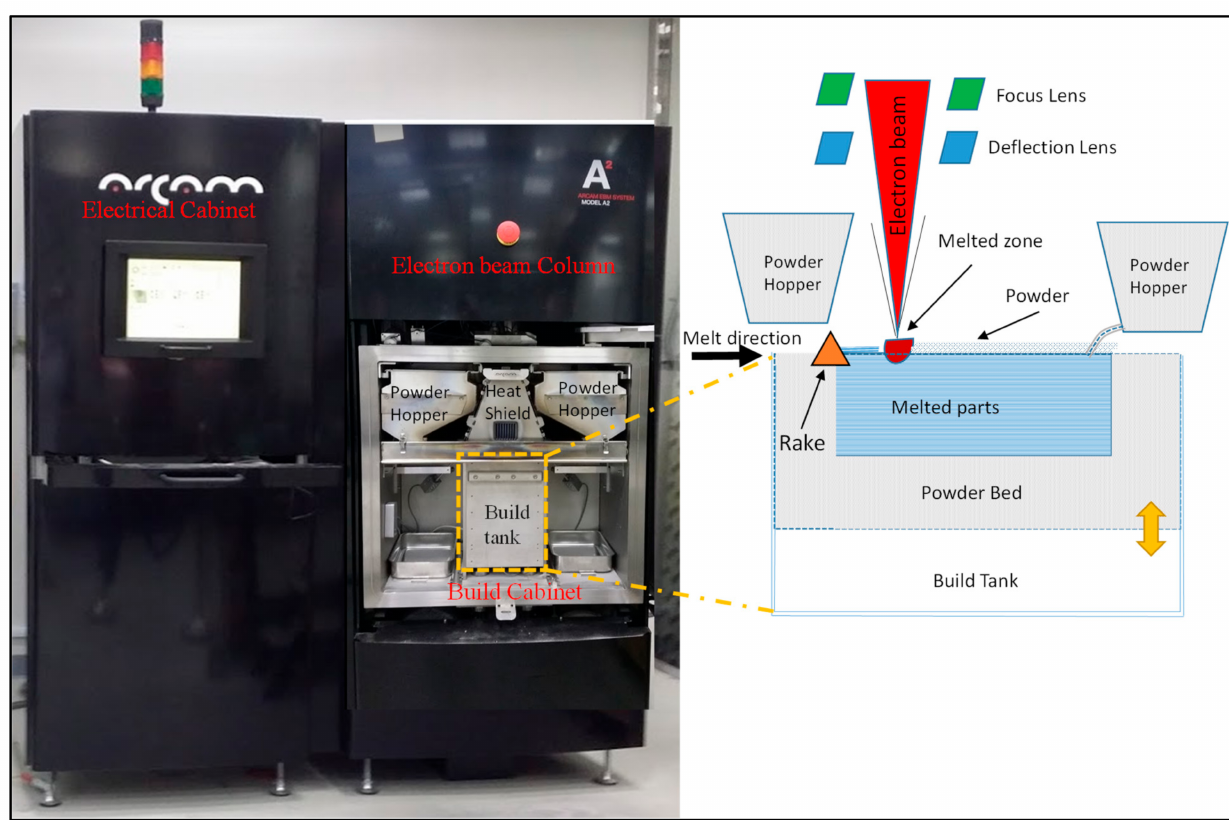
Figure 5. ARCAM’s electron beam melting (EBM) machine with schematic diagram illustrating the fabrication